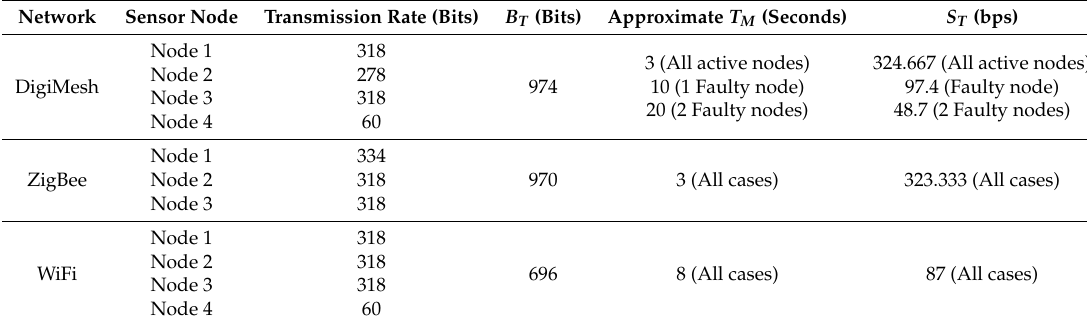
Table 6. Network transmission speed.